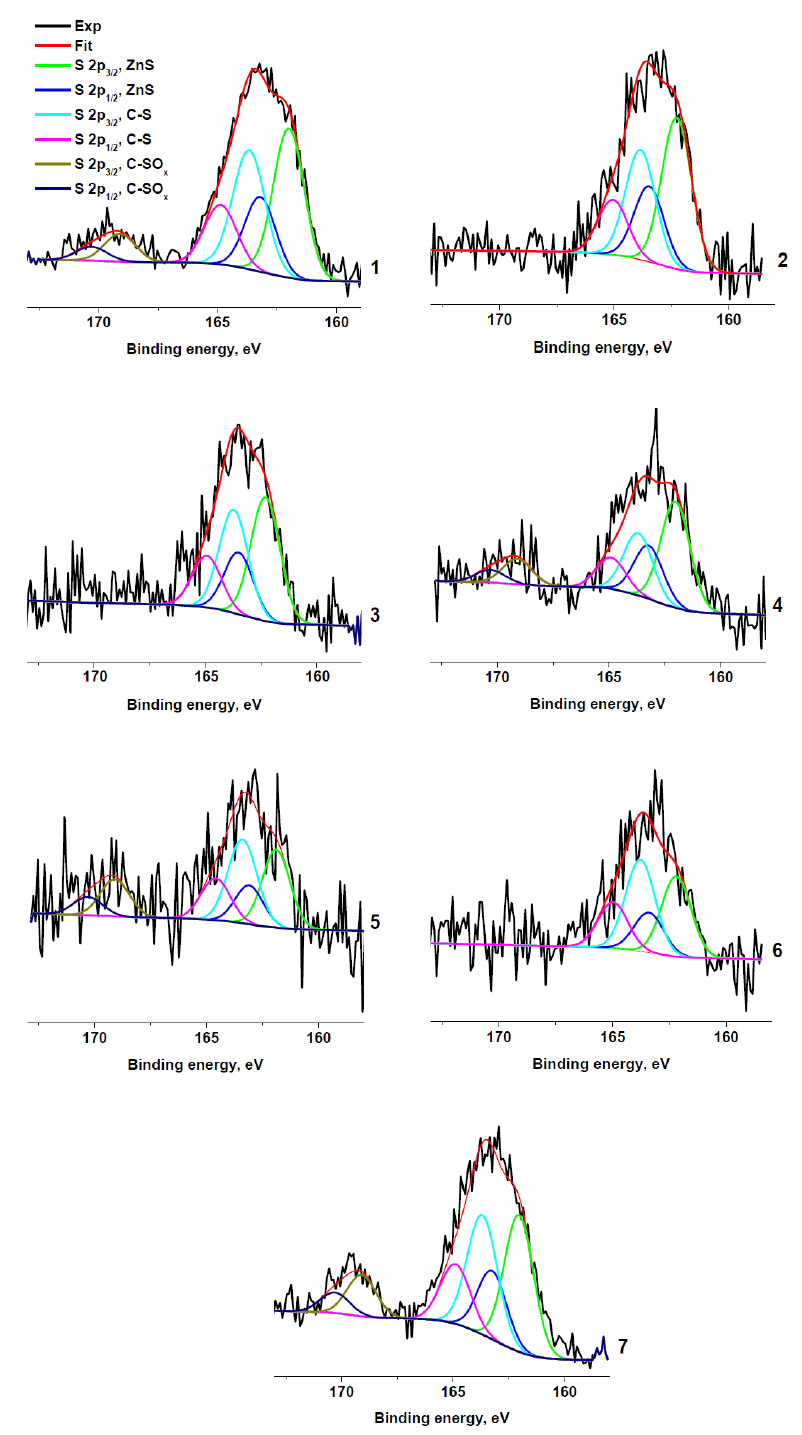
Figure 5. XPS S 2p spectra: RC 0-1a ( 1 ), RC 0-1b ( 2 ), RC 0-1c ( 3 ), RC 1-3b ( 4 ), RC 1-3c ( 5 ), RC 3-5b ( 6 ), and RC 3-5c ( 7 ) (a); fitted S 2p spectrum of RC 3-5c (b).